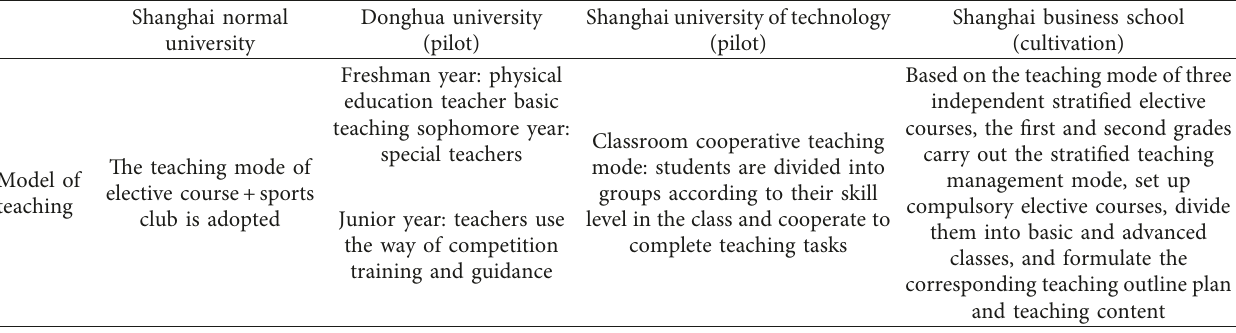
Table 9: Pilot the school teaching model.